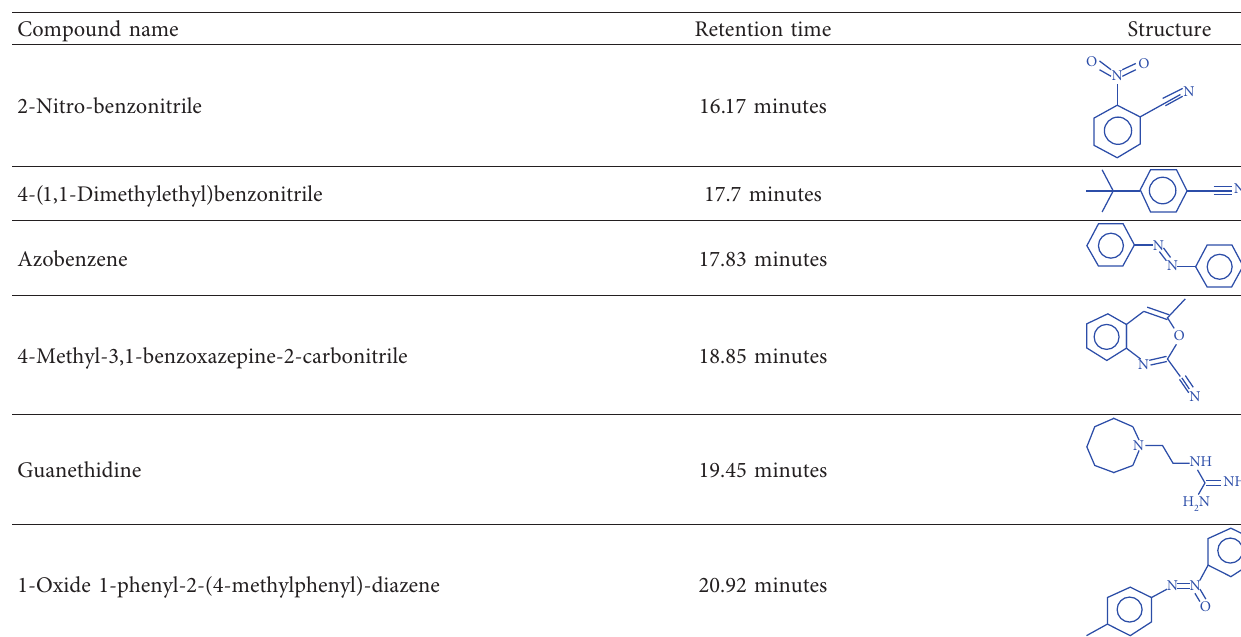
Table 4: Metabolites produced from the degradation of azo dyes in the treated